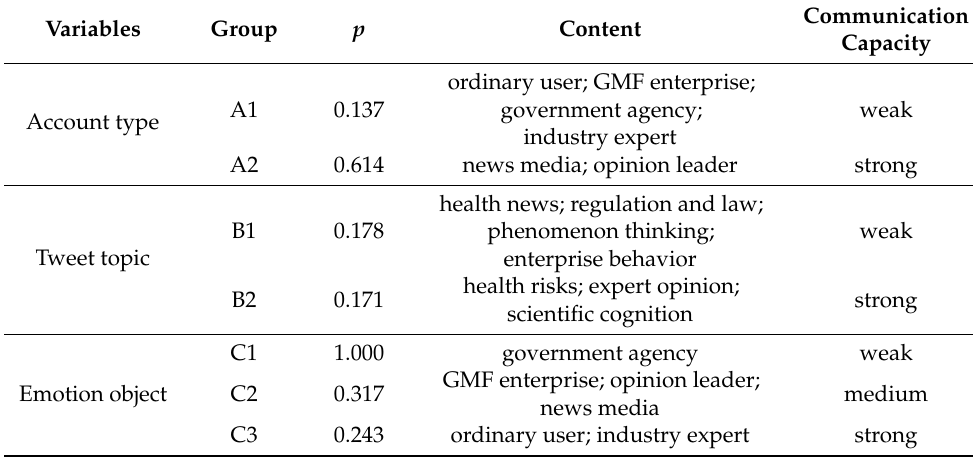
Table 5. SNK test results of emotion communication